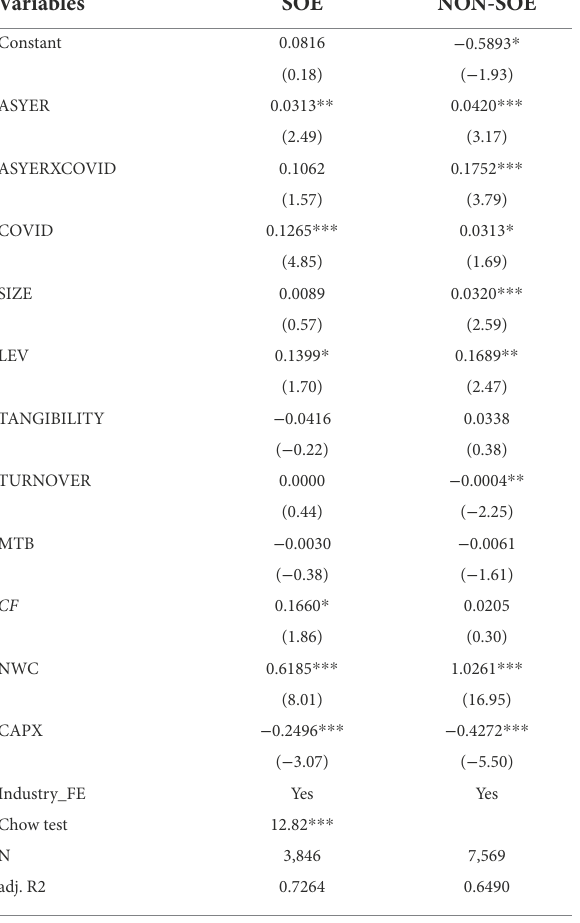
TABLE 7 Information asymmetry, corporate cash holdings and COVID-19: SOEs vs. non-SOEs. Variables